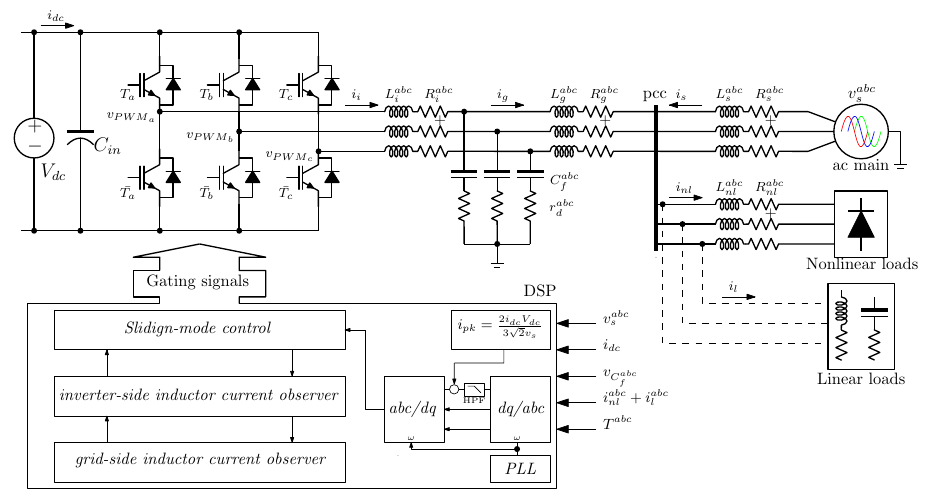
Figure 1. Grid–tied three-phase inverter as active filter functioning.